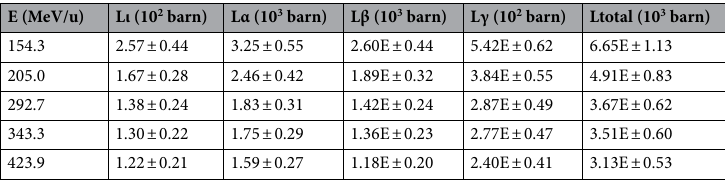
Table 3. Au L-subshell x-ray production cross section induced by high energy C 6+